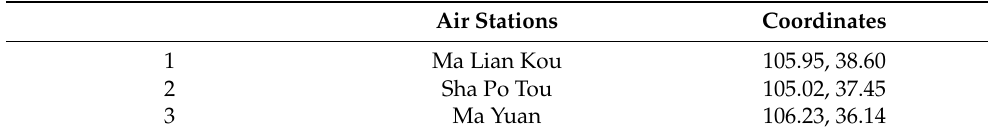
Figure 2. The locations of air monitoring and meteorological stations, where the purple and blue solid point represent the air monitoring stations and meteorological stations in Ningxia, respectively. Table 1. Coordinates of the air monitoring stations in Ning